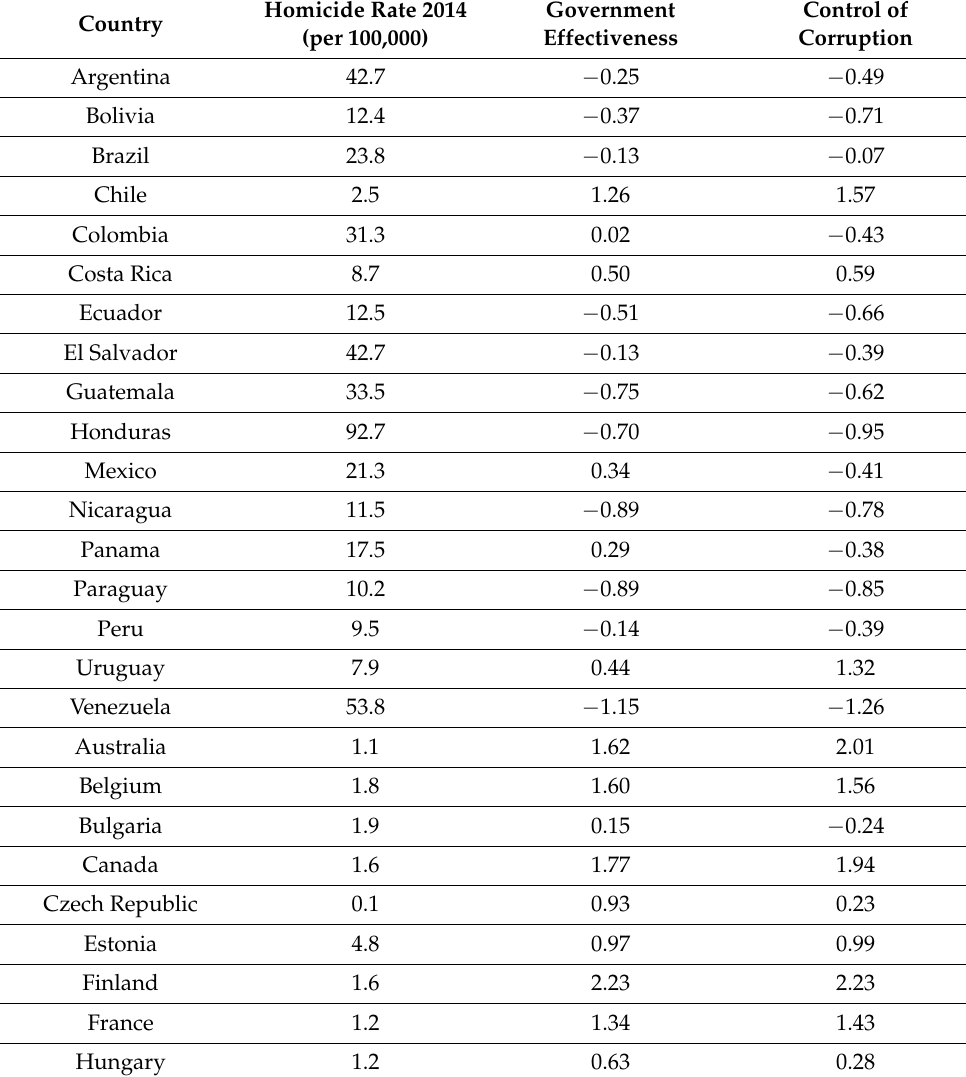
Table A1. Countries included in the research, homicide rates, and WGI measures for government effectiveness and corruption